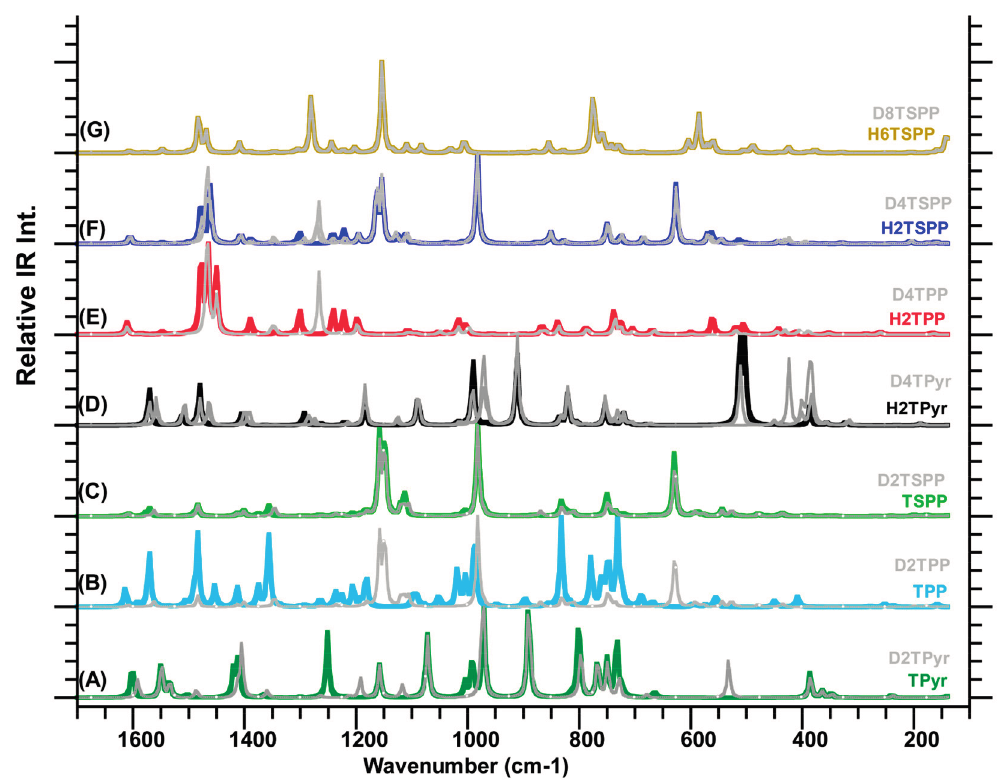
Figure 4. Calculated IR spectra of porphyrin derivatives calculated in water used as solvent at the B3LYP/6-311G(d,p) level of the DFT: (A) free-base porphyrin (TPyr) and deuterated-TPyr (D 2 TPyr); (B) meso -tetraphenylporphyrin (TPP) and (D 2 TPP); (C) anionic meso -tetrakis( p -sulfonatophenyl)porphyrin (TSPP) and deuterated-TSPP (D 2 TSPP), and (D) protonated-TPyr (H 2 TPyr) and deuterated-H 2 TPyr (D 4 TPyr); (E) protonated-TPP (H 2 TPP) and deuterated-H 2 TPP (D 4 TPP); (F) protonated TSPP (H 2 TSPP) and deuterated-H 2 TSPP (D 4 TSPP); and (G) dicationic TSPP (H 6 TSPP) and deuterated-H 6 TSPP (D 8 TSPP). It should be noted that the plot IR spectra in the gray color belong to the deuterated